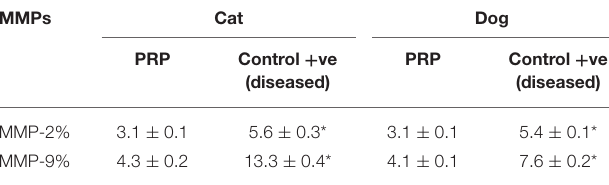
TABLE 8 | Gelatin zymography